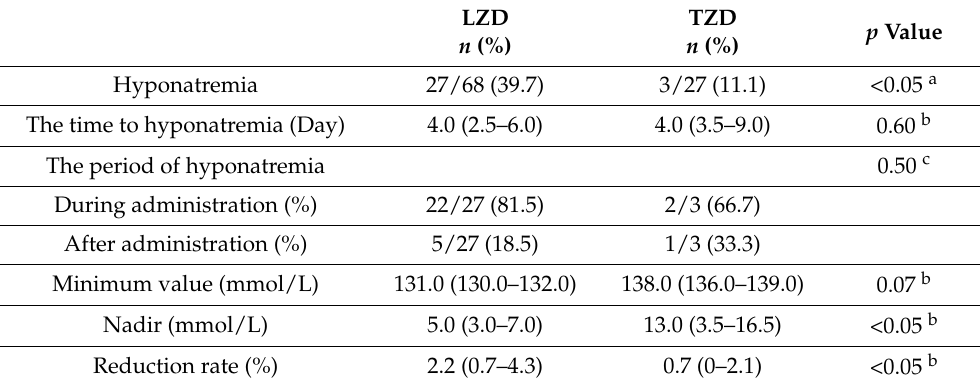
Table 5. Clinical data with hyponatremia after oxazolidinone treatment.